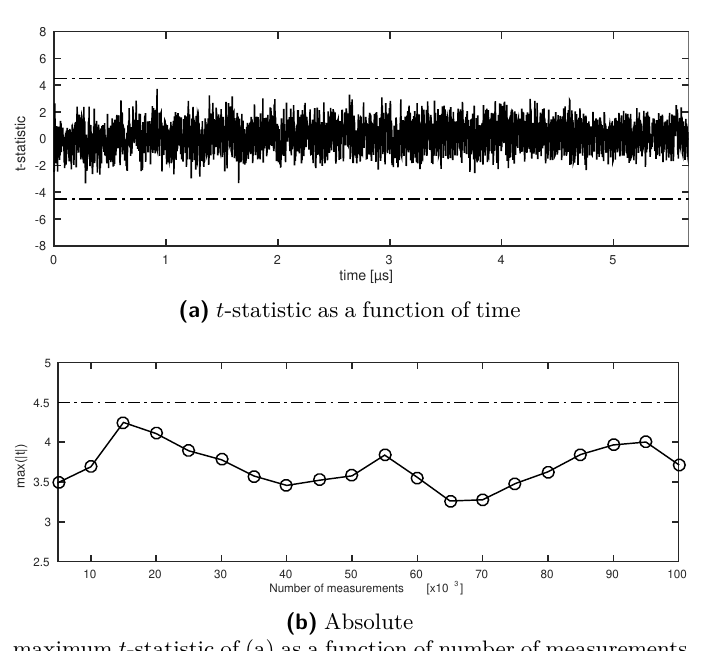
Figure 7: TVLA of Debraize (fixed) for a pool of 100.000